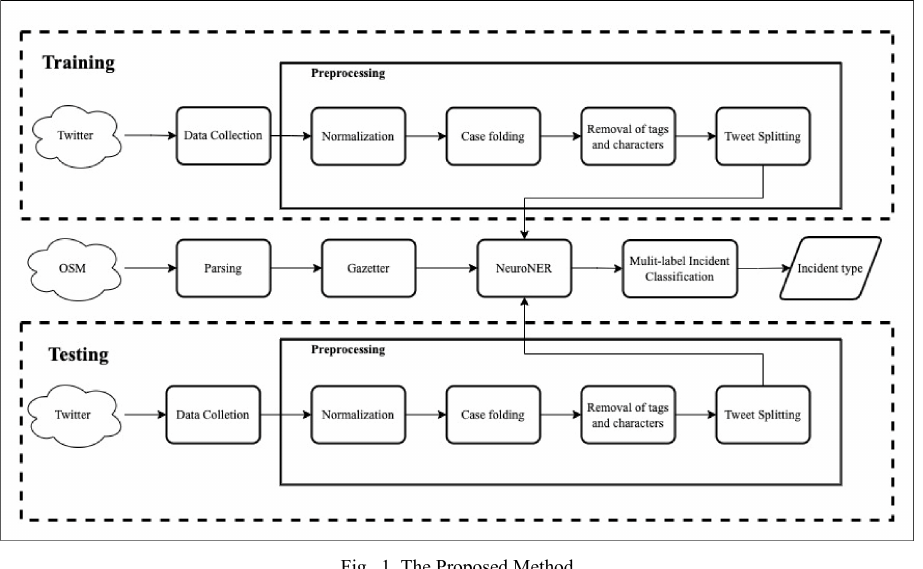
Fig. 1. The Proposed Method III. M